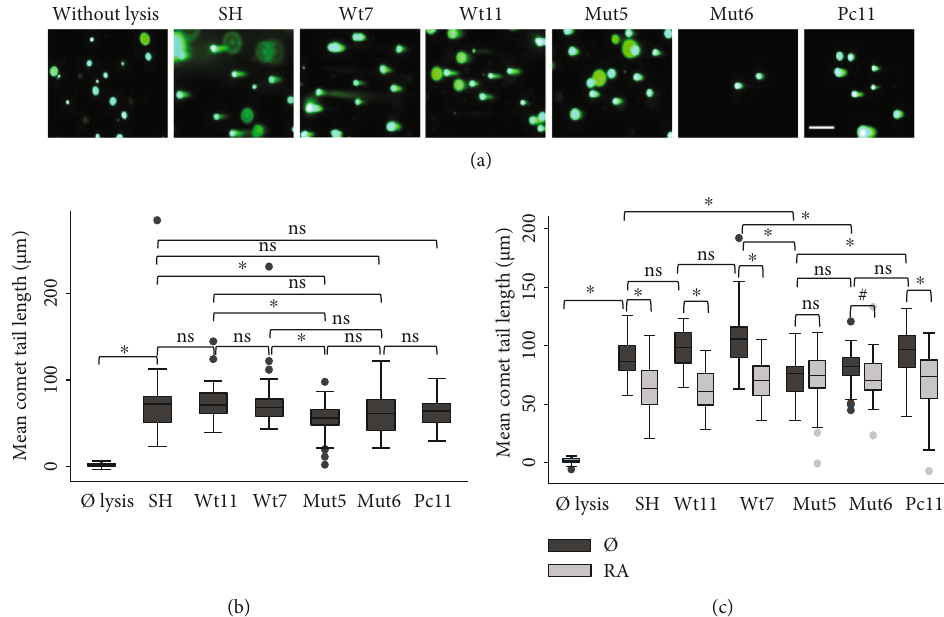
Figure 2: Comet tail lengths or DNA double-strand breaks (a) in the SH-SY5Y cells (SH), in the clones with the PS1 human gene (Wt7 and Wt11), with the P117L PS1-mutated gene (Mut5 and Mut6), and with the transfected vector pcDNA3 alone (Pc11) in comparison to cells without lysis. Scale bar: 200 μ M. (b) Box plots of mean comet tail lengths (in μ M) of SH cells and Wt and Mut clones (number of cells measured: 31 < n < 56 ). Comet tail lengths were signi fi cantly shorter in the Mut clones compared to the Wt clones. (c) 5 μ M RA treatment for 30 min reduced tail length particularly in the Wt cells and less so in the Mut clones (number of cells measured: 30 < n < 58 ) including the Mut6 clone ( # p = 0 : 058/mean and p = 0 : 03/variance Kruskal ). ANOVA with Bonferroni test: ∗ p < 0 : 05 ; ns: nonsigni fi